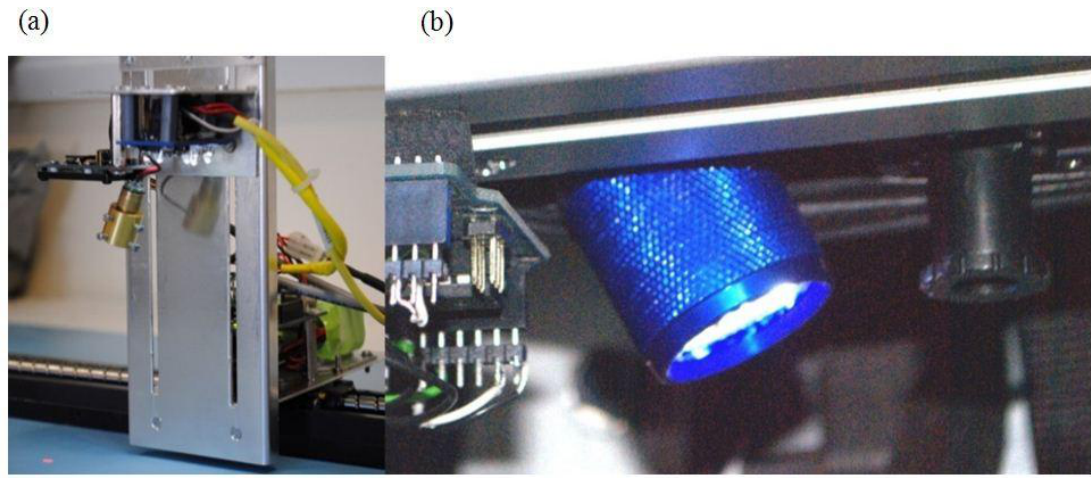
Figure 1. ( a ) Mouse camera with laser illumination and color sensor with white LED illumination; ( b ) Improved and final configuration with mouse camera and lens, and color sensor both illuminated by white